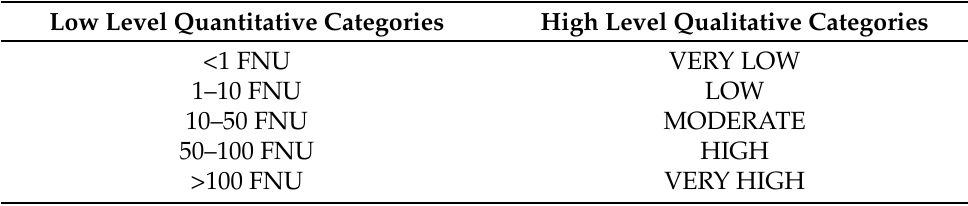
Table 1. Turbidity classes and association between low and high level categories.